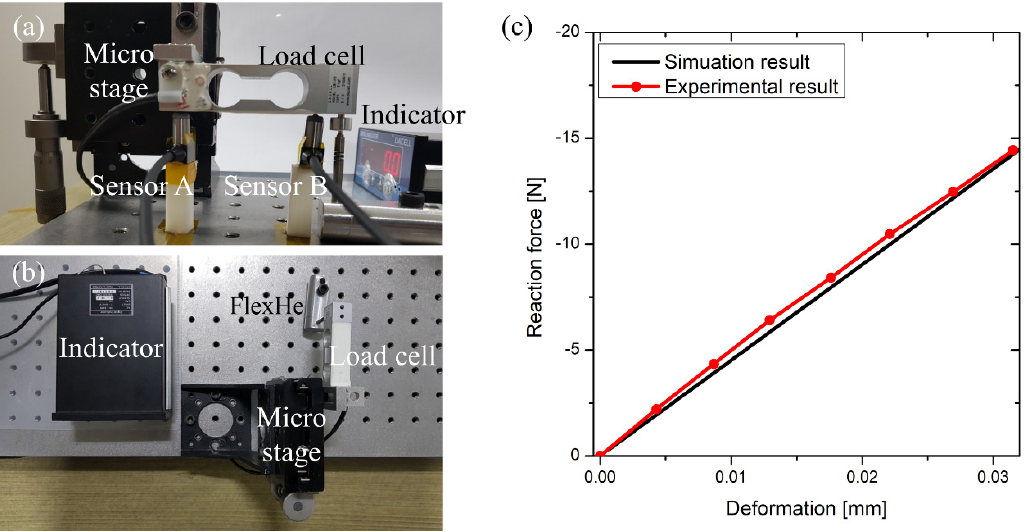
( b ) top view, and ( c ) a plotted graph of deformation versus the reaction force (Black line: simulation result, Red dotted line: experiment result).